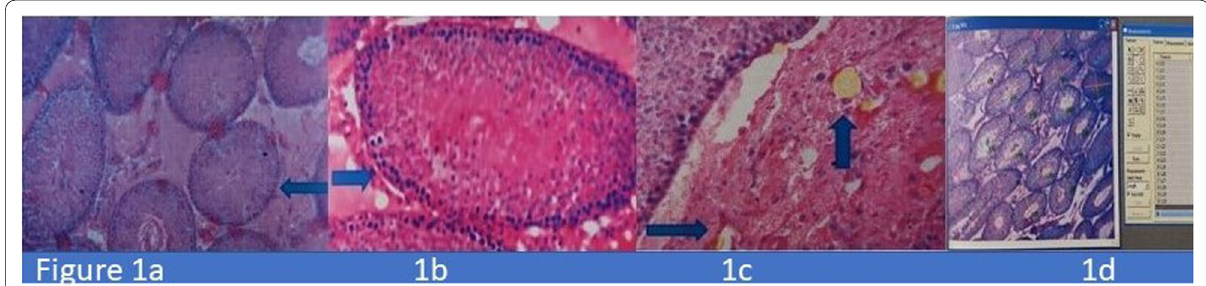
Fig. 1 a Normal testicular parenchyma in Group I. b Mild inflammation in Group III at 70 days of life. c Inflammation around suture material in Group III at 120 days of life. d Seminiferous tubular diameter in Group I at 70 days of